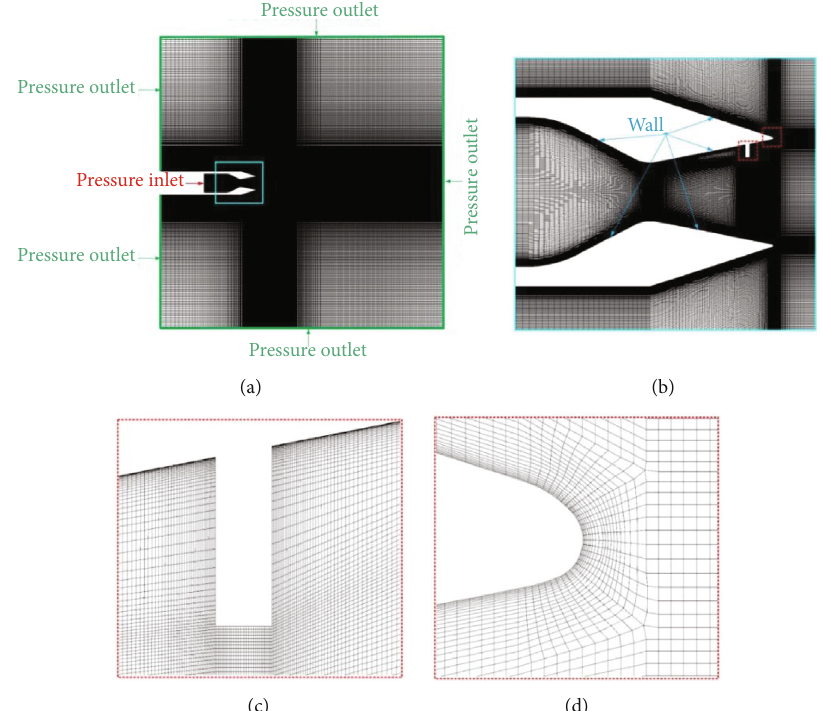
Figure 4: Computational domain and boundary conditions: (a) overall view; (b) local view; (c) zoom-in view around the rod; (d) zoom-in view close to the nozzle